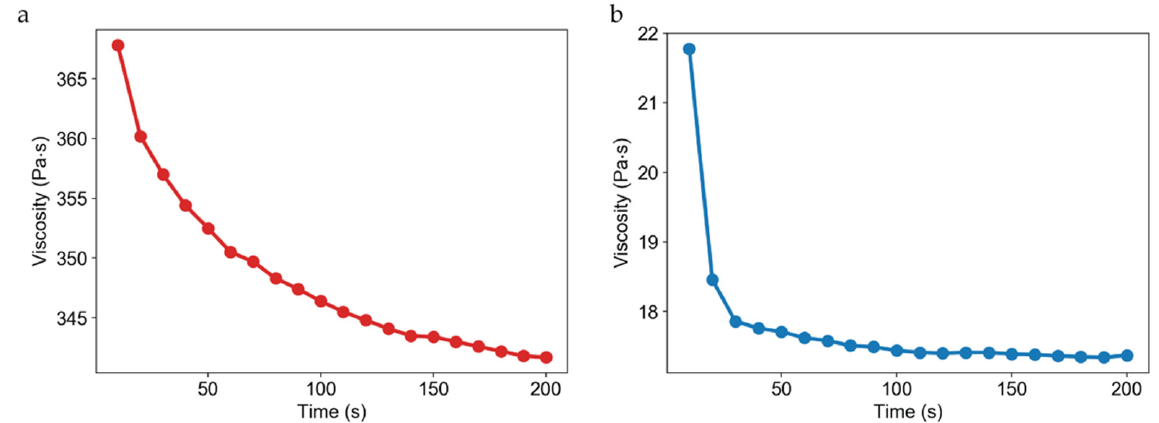
Figure 4. Viscosity of CHA and CA scaffolds. Rheological data of 4 wt % ( a ) CA and ( b ) CHA scaffold solutions. Viscosity is plotted against time showing both scaffold solutions have a shear thinning characteristic.